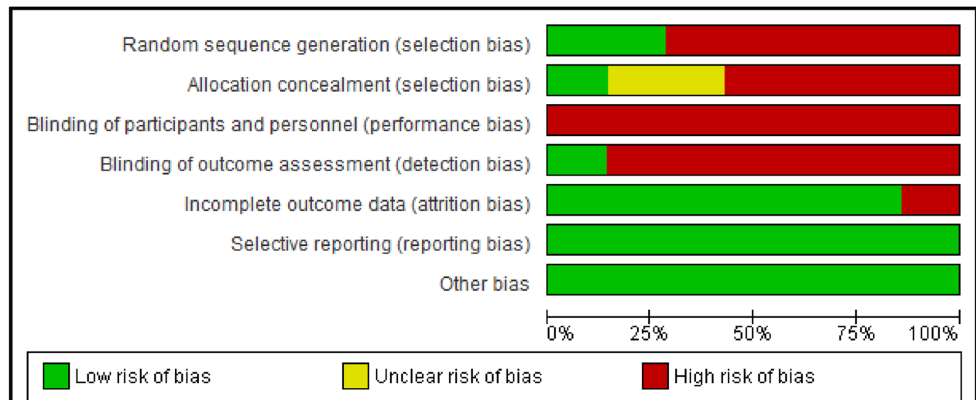
Figure 2. Risk of bias graph: review authors’ judgements about each risk of bias item presented as percentages across all included